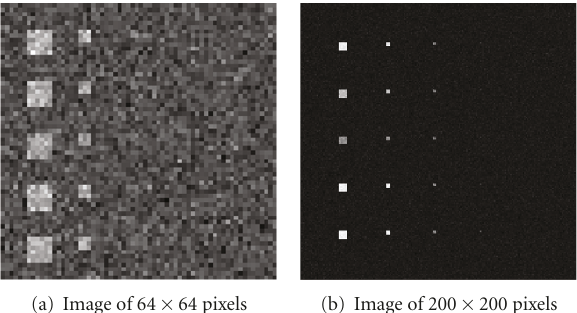
Figure 10: Results of operating RXD on images in Figures 9(a) and